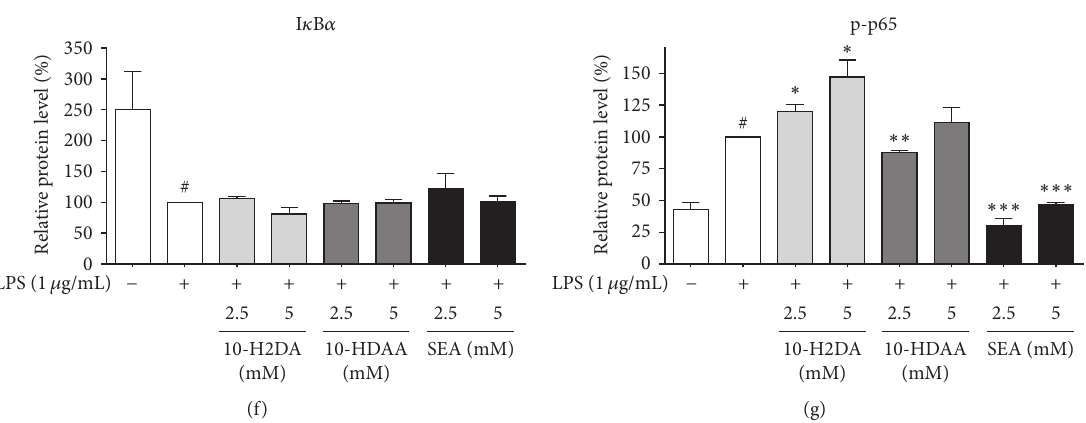
Figure 6: Effects of 10-H2DA, 10-HDAA, and SEA on the phosphorylation of MAPK and NF- 𝜅 B pathways in LPS-stimulated RAW 264.7 cells. (a) RAW 264.7 cells either were pretreated with 10-H2DA, 10-HDAA, and SEA at the indicated concentrations for 1h or received no such pretreatment. They were then stimulated with LPS (1 𝜇 g/mL) for 30 min. Whole cell lysates were analyzed by Western blotting analysis using specific antibodies. The relative expression of proteins was quantified using Quantity One software, comparing with 𝛽 -tubulin. Data shown are the representative of three independent experiments with similar results. (b–g) The intensity of corresponding bands was measured by densitometry and normalized to 𝛽 -tubulin. The values are the means ± SEMs. Individual groups were compared by Student’s t -test ( ∗ 𝑃 < 0.05 , ∗∗ 𝑃 < 0.01 , and ∗∗∗ 𝑃 < 0.001 compared with the LPS group; # 𝑃 < 0.05 compared with untreated group).